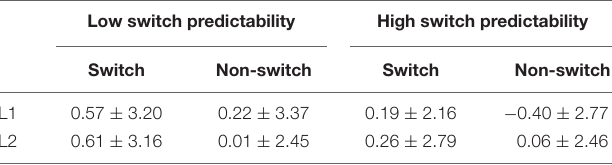
TABLE 3 | Mean amplitudes and standard errors of the early phase elicited by digits.